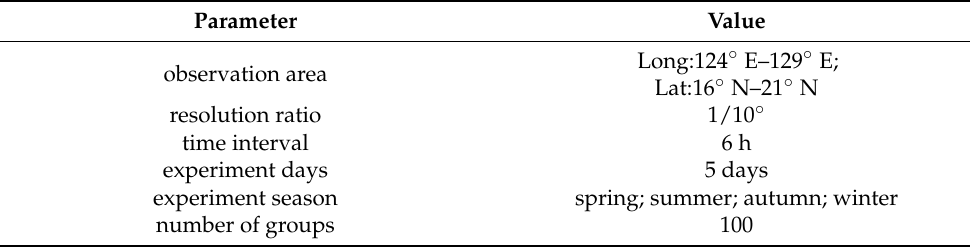
Table 2. Parameter settings of the data assimilation